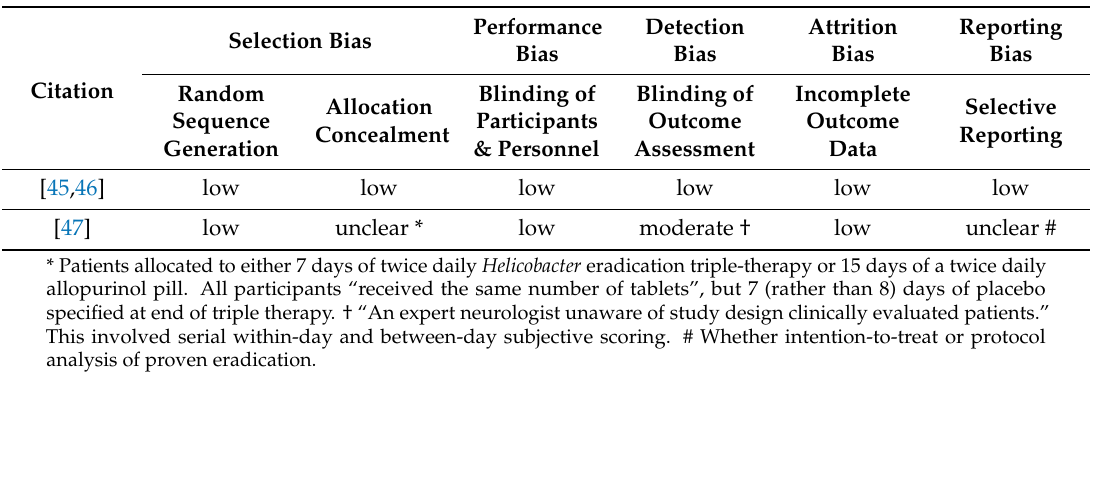
Table 6. Risk of bias assessment of randomised placebo-controlled